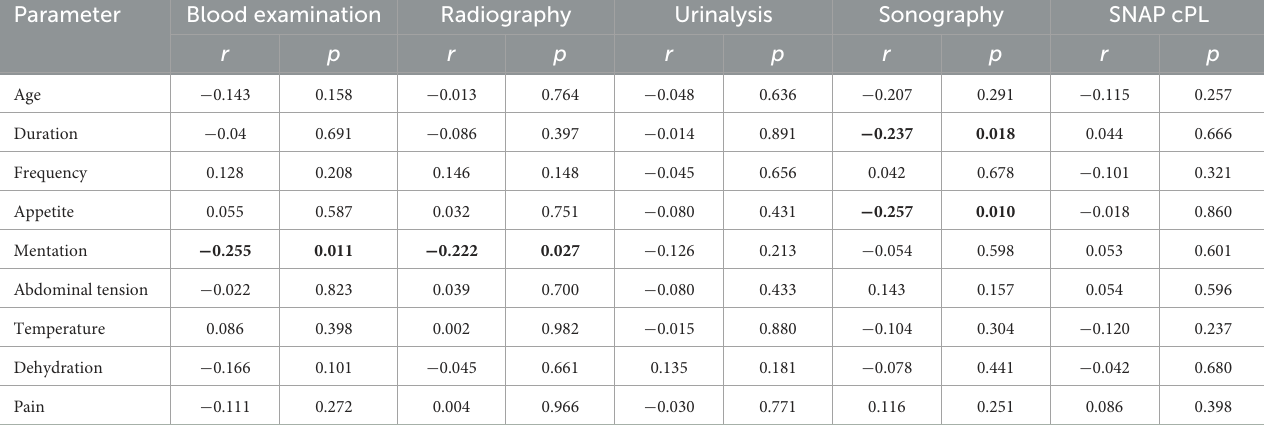
TABLE 3 Spearman correlation between clinical parameters and utility score of different diagnostic tests in 99 dogs with vomiting. Parameter